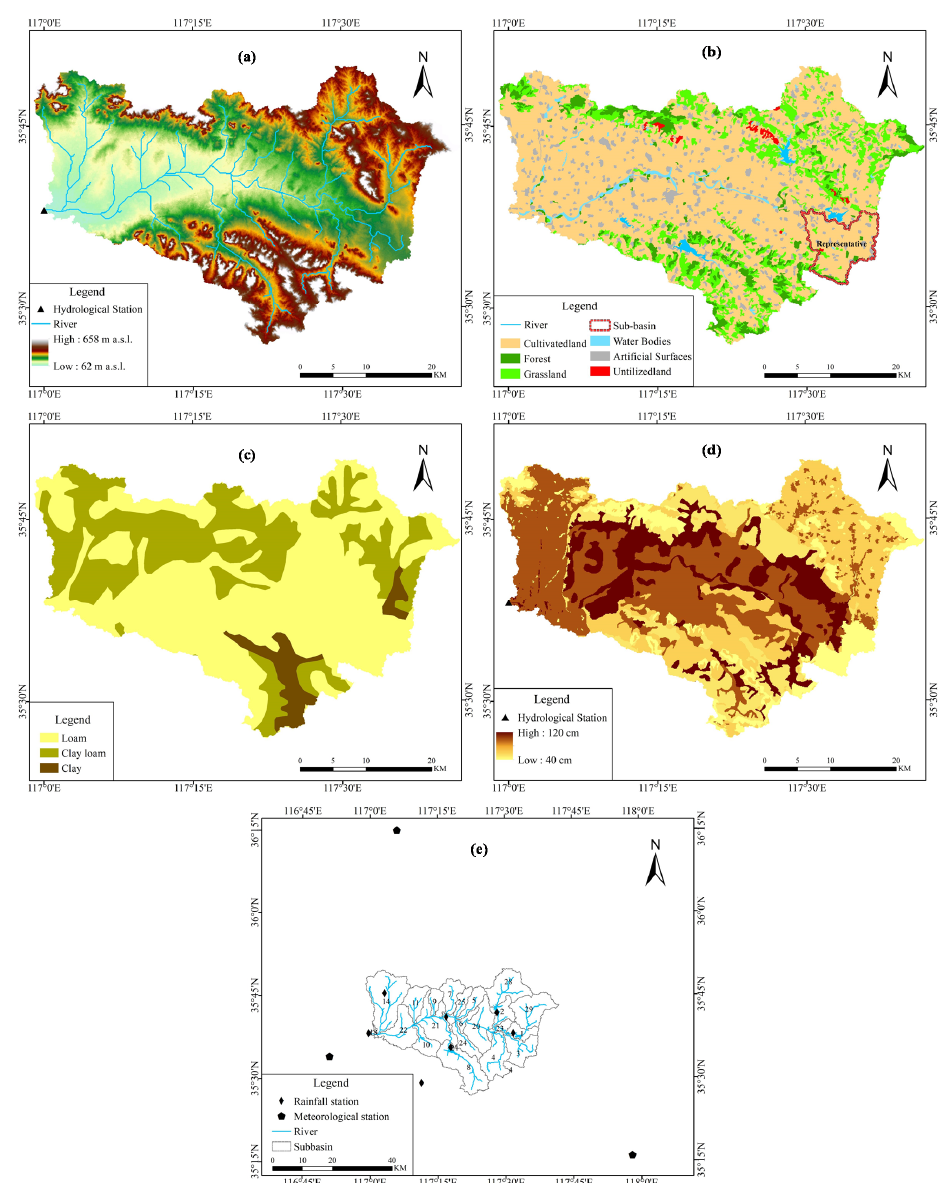
Figure 3. Basic information of study area: ( a ) basin topography, ( b ) basin land use and studied sub-basin, ( c ) soil type of basin, ( d ) soil thickness of basin, ( e ) meteorological station and rainfall station.